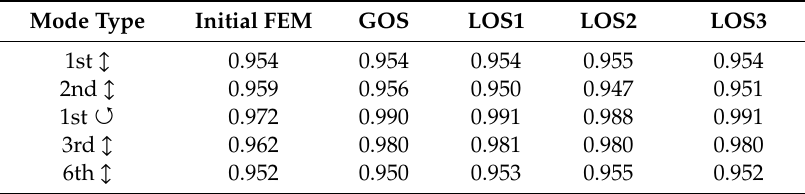
Table 13. MAC values corresponding to each group of